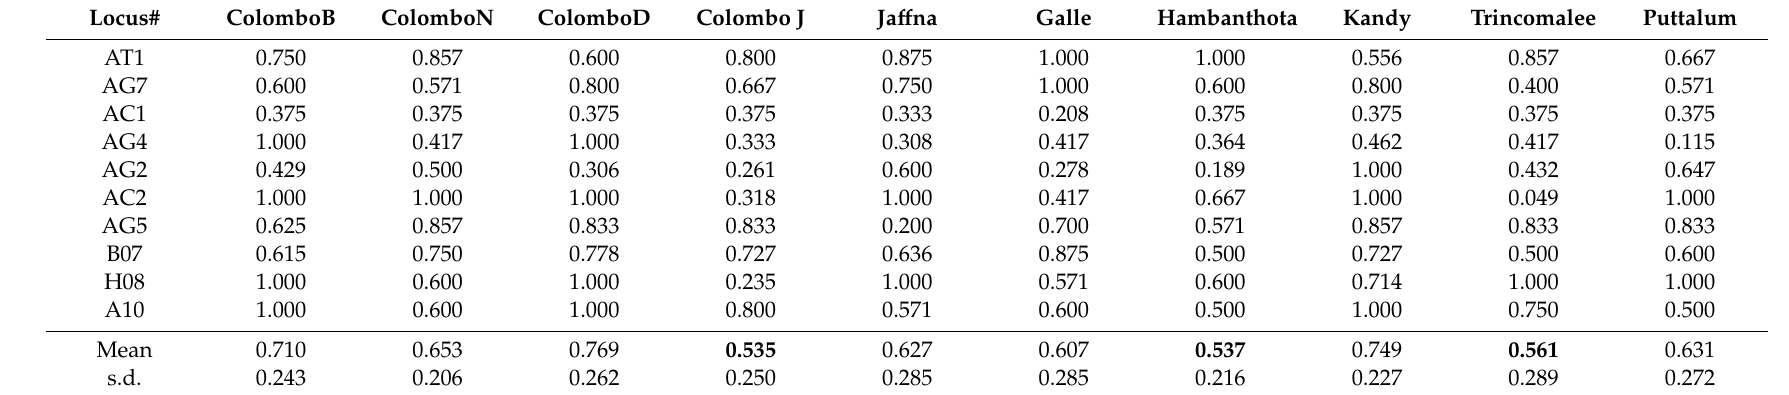
Table 2. Garza Williamson index for the 10 microsatellite loci calculated at each of the 10 populations from Aedes aegypti in Sri